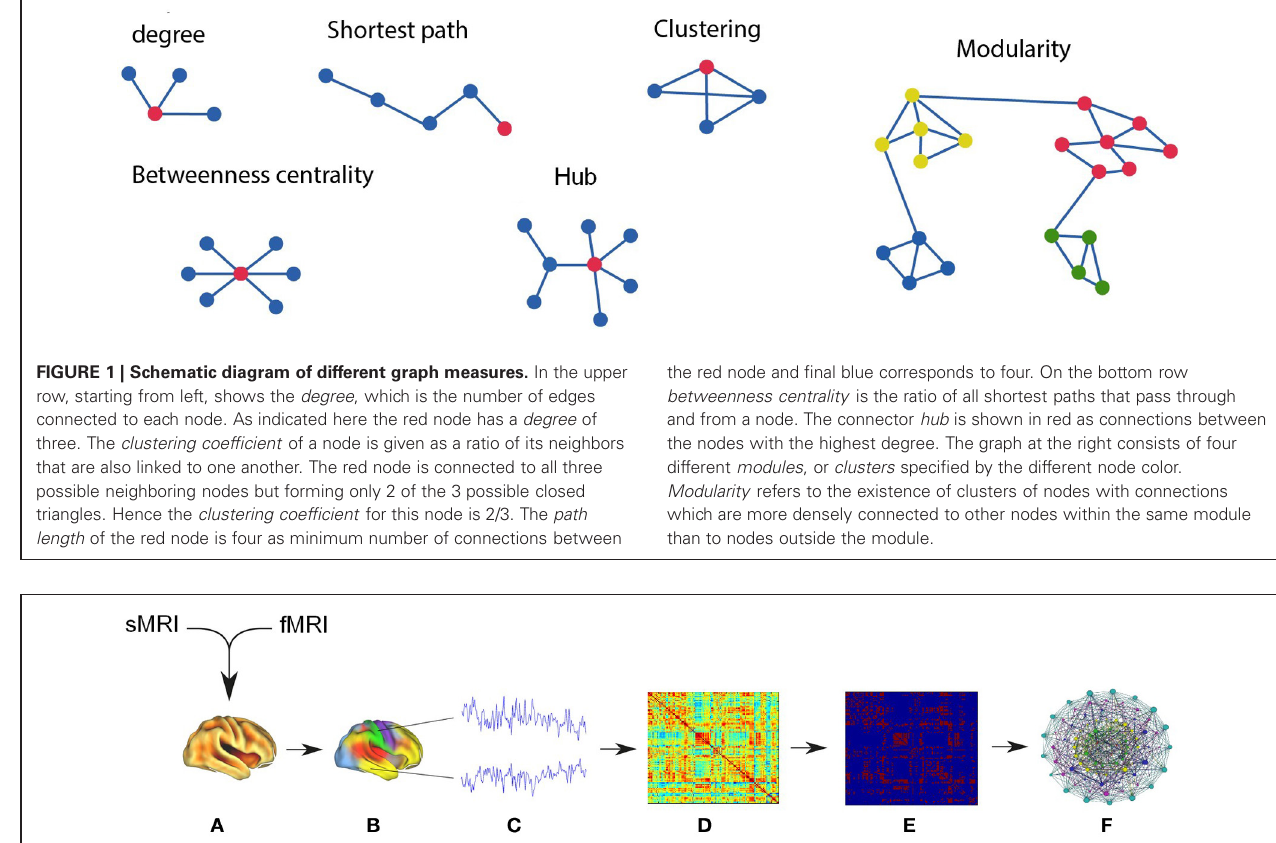
FIGURE 2 | The diagram represents data analysis workflow. (A) Initial data pre-processing and co-registration of structural and functional data. (B) Application of parcellation scheme anatomical template image to each individual fMRI dataset creating a regional mean fMRI time series. (C) Wavelet analysis was used to bandpass filter the regional time series